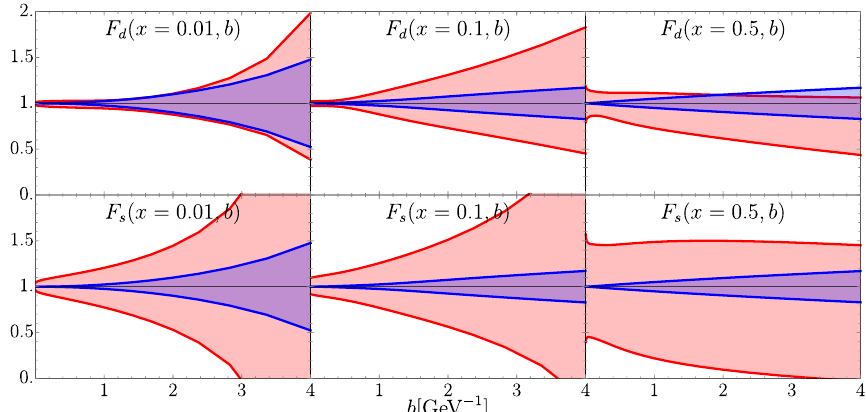
Figure 8 . The size of the uncertainty bands for unpolarized TMDPDFs due to collinear PDF uncertainty (red band) and due to experimental uncertainties (blue band), for d and s-quarks at di(cid:11)erent values of x . Both bands are weighted to the TMPDF obtained with NNPDF31 collinear